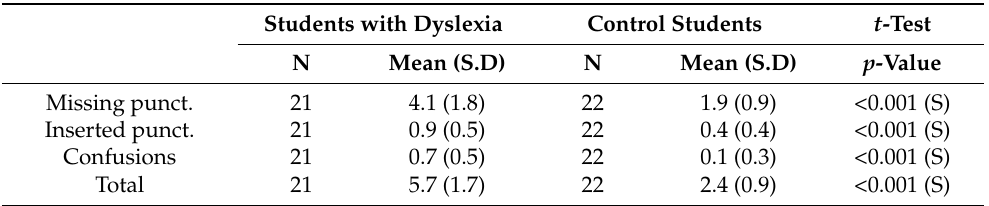
Table 6. Average error rates concerning punctuation in both groups (mean, SD, and Welch p -value: NS = non significant/S = significant). Students with Dyslexia Control Students t -Test N Mean (S.D) N Mean (S.D) p -Value Missing punct. 21 4.1 (1.8) 22 1.9 (0.9) <0.001 (S) Inserted punct. 21 0.9 (0.5)